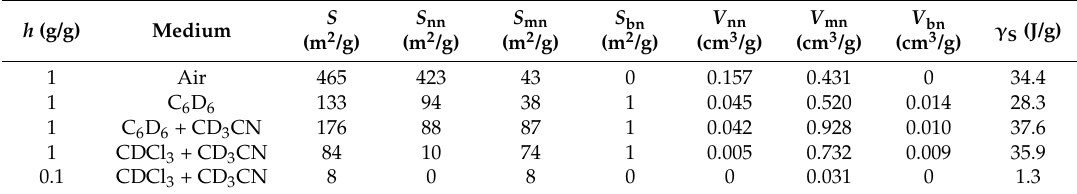
Table 2. Structural characteristics of gelatin gel based on NMR cryoporometry.